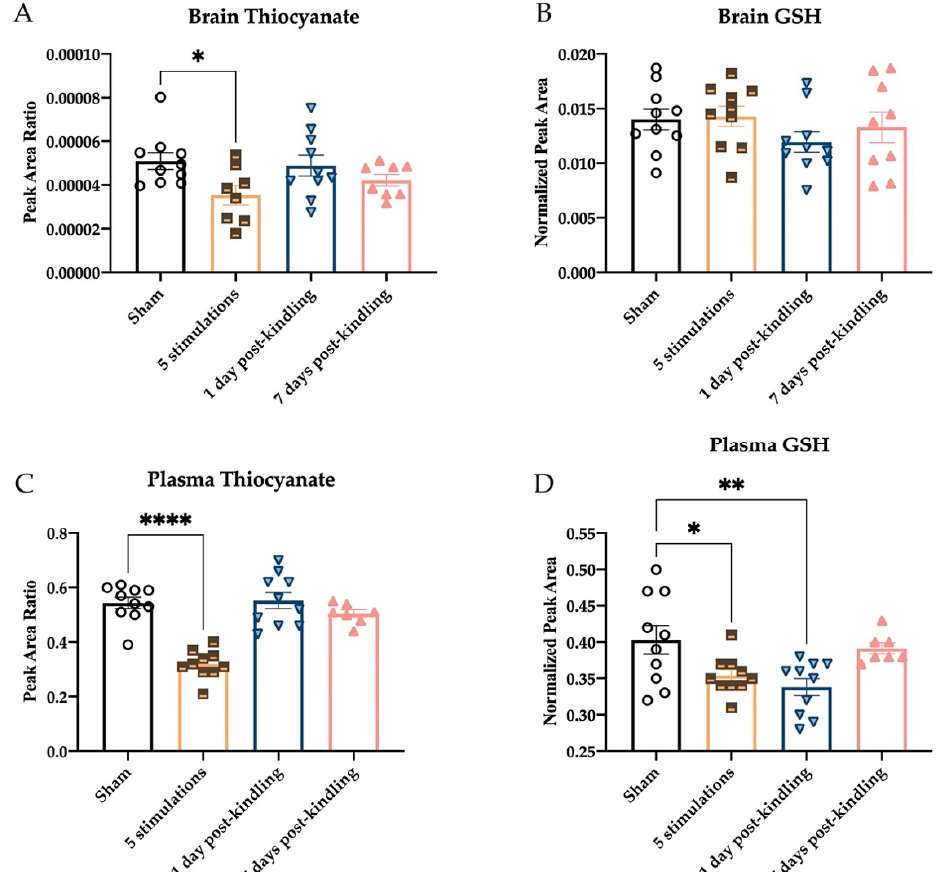
Figure 5. The levels of thiocyanate and reduced glutathione (GSH) were quantified in the brains and plasma of male mice with time following induction of the corneally kindled model of temporal lobe epilepsy. Data are presented as mean +/ − S.E.M. ( A ) Changes in whole brain thiocyanate levels were significantly reduced 1 h after the 60 Hz transcorneal stimulation needed to induce the fully kindled state, but there was no difference from sham-kindled mice when assessed 1 day and 7 days post-kindling. ( B ) The levels of GSH in the whole brain were not significantly different from those of sham-kindled mice when assessed after the fifth stimulation or 1 day or 7 days post-kindling. ( C ) The levels of thiocyanate in purified plasma were significantly reduced in mice euthanized 1 h after the fifth transcorneal stimulation, but the levels were no different from those of sham-kindled mice when assessed 1 day or 7 days post-kindling. ( D ) The levels of GSH in the plasma were significantly reduced in mice euthanized 1 h after the fifth transcorneal stimulation, as well as in mice euthanized 1 day after the acquisition of the fully kindled state. However, levels of GSH were no different from those of sham-kindled mice when assessed 7 days post-kindling. * Indicates significant difference from sham-kindled mice, * p < 0.05, ** p < 0.01, **** p <